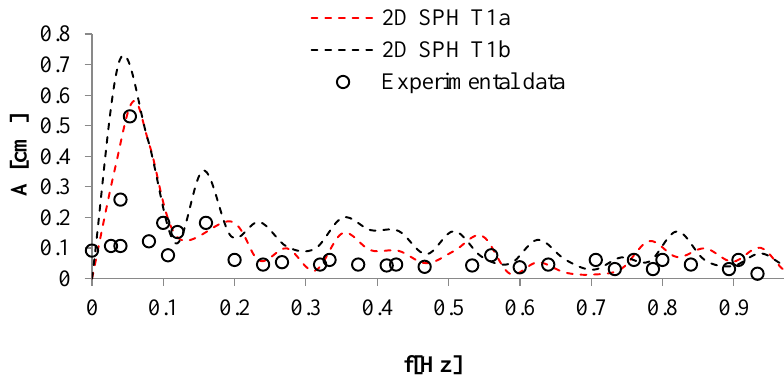
Figure 9. Amplitude spectrum of pressure fluctuations under the hydraulic jump (configuration B32 of Table 1) for the SPH simulations of test T1 and two different turbulence models: mixing-length (T1a) and k-ε (T1b).